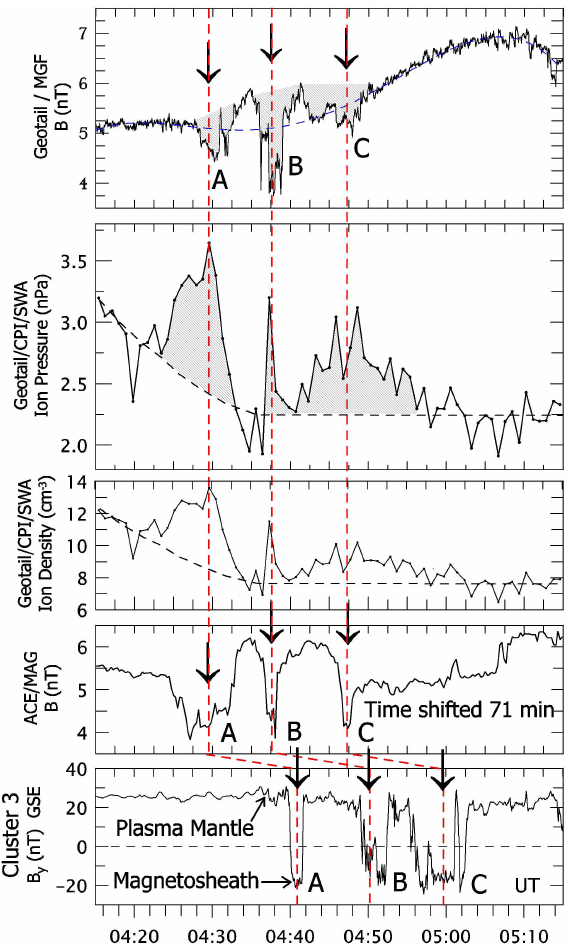
Fig. 5. From top to bottom: (a) the IMF amplitude (innT) recorded by Geotail, showing three major depressions marked with the cap- ital letters A, B and C; (b) the solar wind ion pressure (in nPa) and density (in cm − 3 ) measured by Geotail; (c) the ACE satel- lite magnetic field amplitude shifted in time 71min to match the Geotail data, and (d) the Cluster 3 B y component of the magnetic field showing three intermittent exits of the satellite from the plasma mantle into the